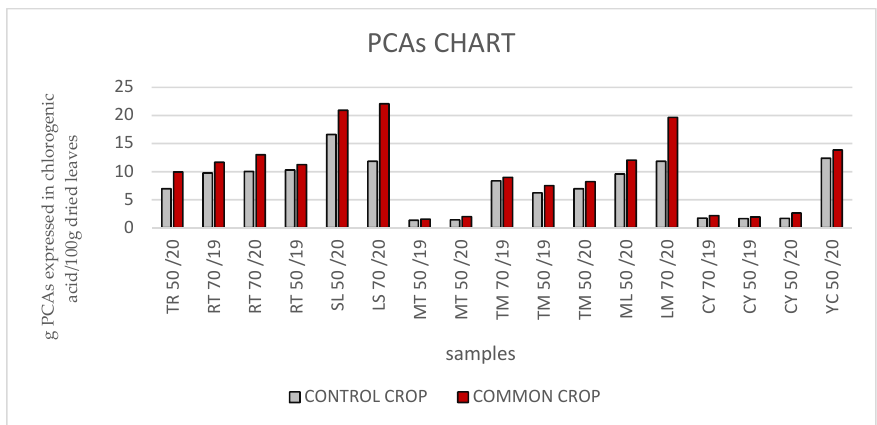
Figure 17. Graphic representation of total flavones content.